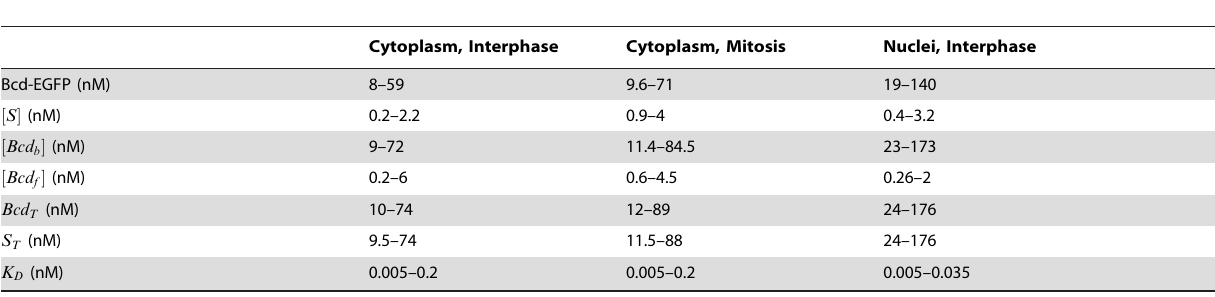
Table 4. Absolute values of concentrations and of the binding/unbinding dissociation constant.